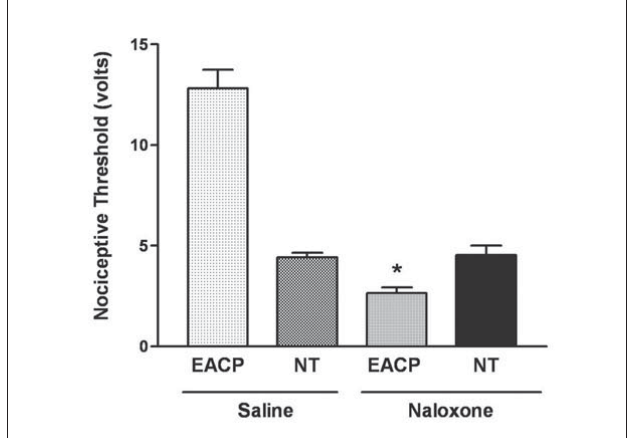
Fig. 5. Male-female differences in analgesic effect after low-frequency electroacupuncture (EACP) treatment in rabbit tooth pulp assay. The nociceptive threshold was measured after 120 min EACP (Yintang, ST4, ST5 acupoints; 2 Hz, 30 mA) procedure in males and females. The points represent the means ± SEM of 6 animals per group. Asterisks indicate statistically significant differences between the NT group and the others (*p<0.05, Student’s